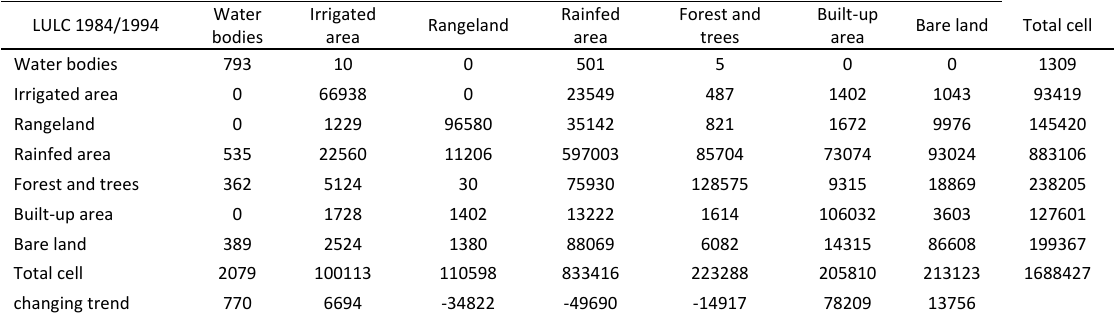
Table 6c: Probability of transition class for LULC 1994-2004 (round two)